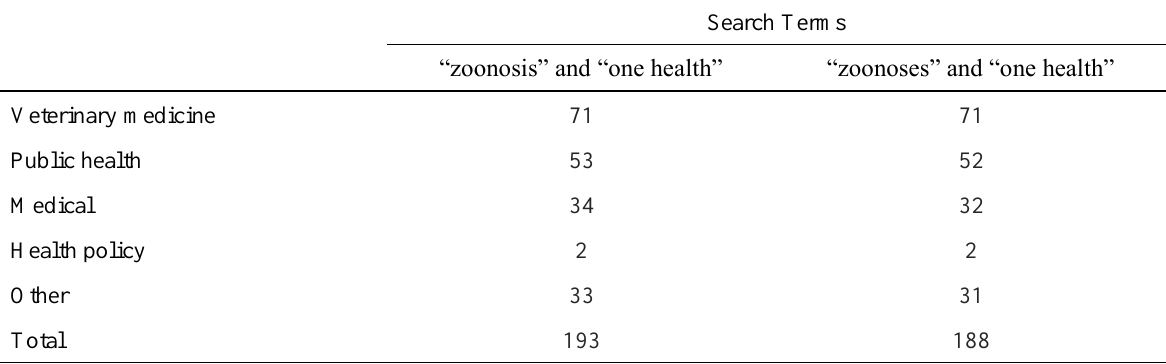
Table 3: Stratification of articles by discipline for advanced search terms in PubMed